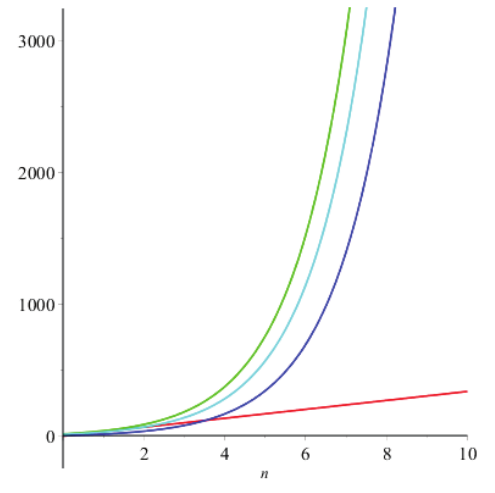
Figure 6: Sum Connectivity Index .